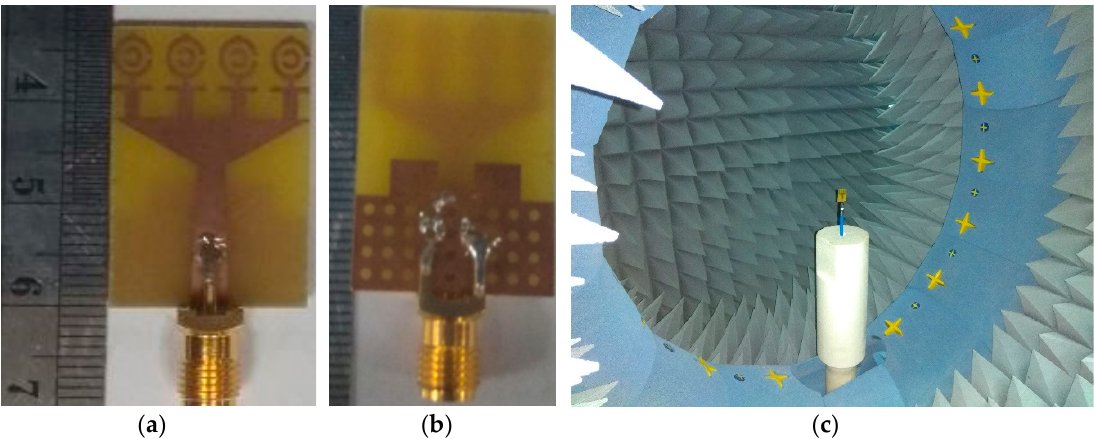
Figure 8. The photograph of the proposed ultrawideband (UWB) antenna ( a ) top view and ( b ) back view, and ( c ) UKM StarLab.